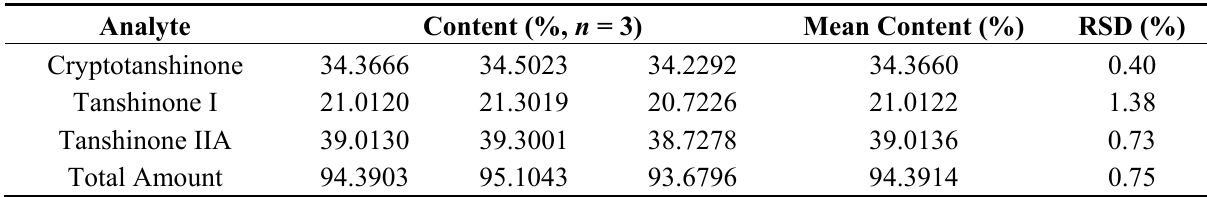
Table 5. Contents of the three compounds contained in the S. miltiorrhiza Bunge reference extractive.